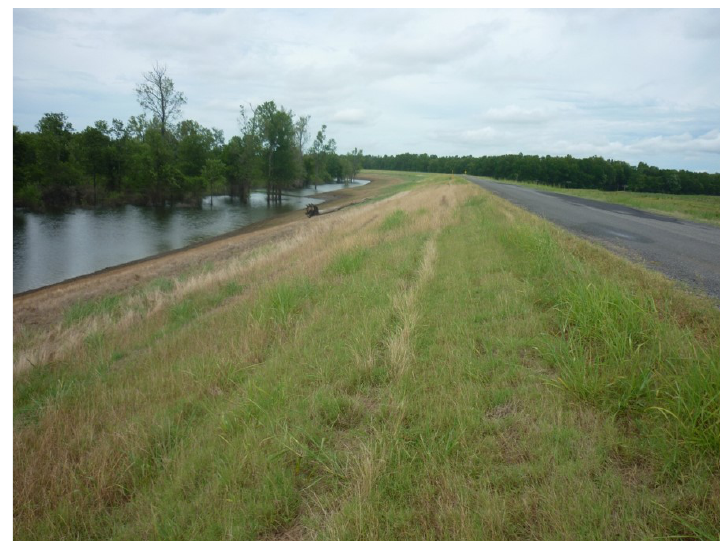
Figure 4. Earthen Levee on the banks of Albemarle Lake, MS, USA, a Mississippi River oxbow.